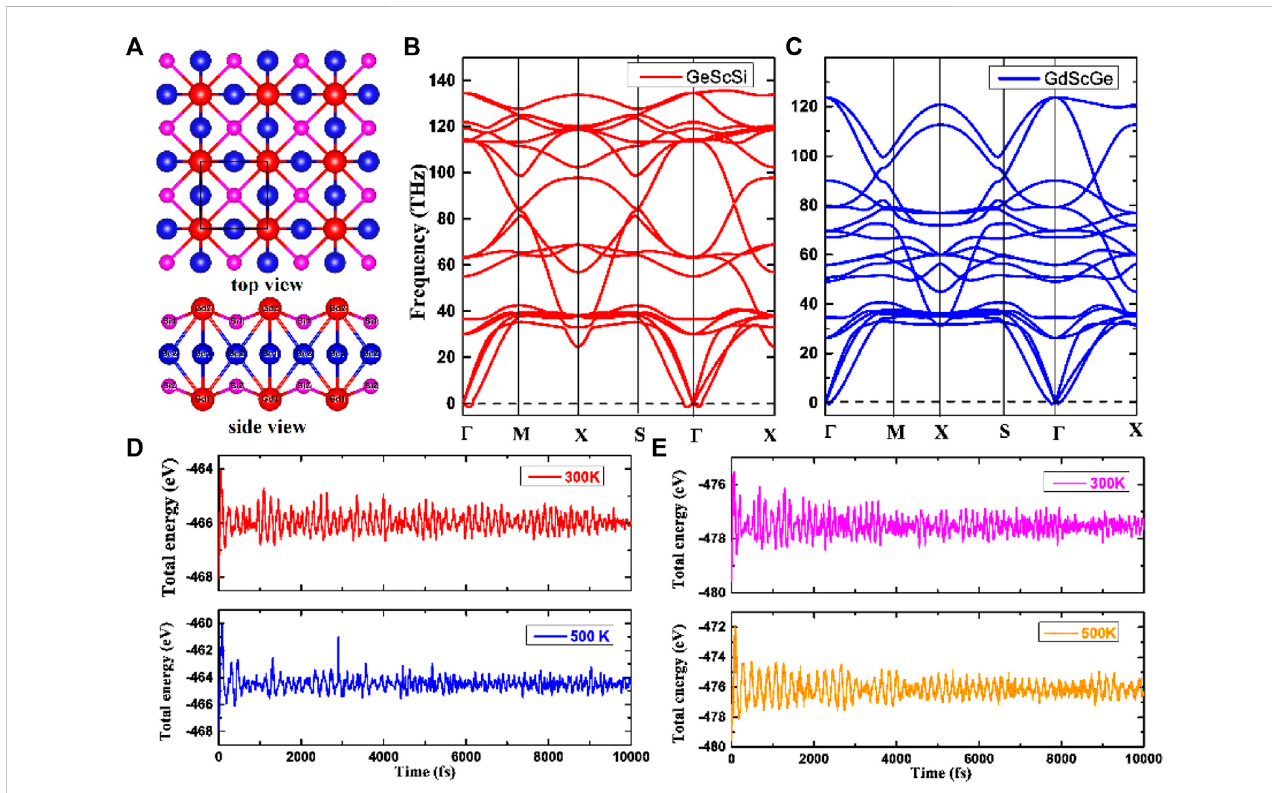
FIGURE 1 (A) Structures of GdScX ( X = Si, Ge) monolayers. The Gd atom is located at 2 g (0, 0, 0.3633), Sc at 2e (1/2, 0, 1/2), and Si at 2 h (1/2, 1/2, 0.5971) for the GdScSi monolayer.The Gdatomislocated at2 g (0,0, 0.3628), Scat2e(1/2, 0,1/2), andGe at2 h(1/2,1/2, 0.5988) fortheGdScGemonolayer. (B, C) Phonon dispersion spectra of the GdScX ( X = Si, Ge) monolayers. (D, E) Evolution of the total energy from the 10 ps AIMD simulations at 300 K and 500